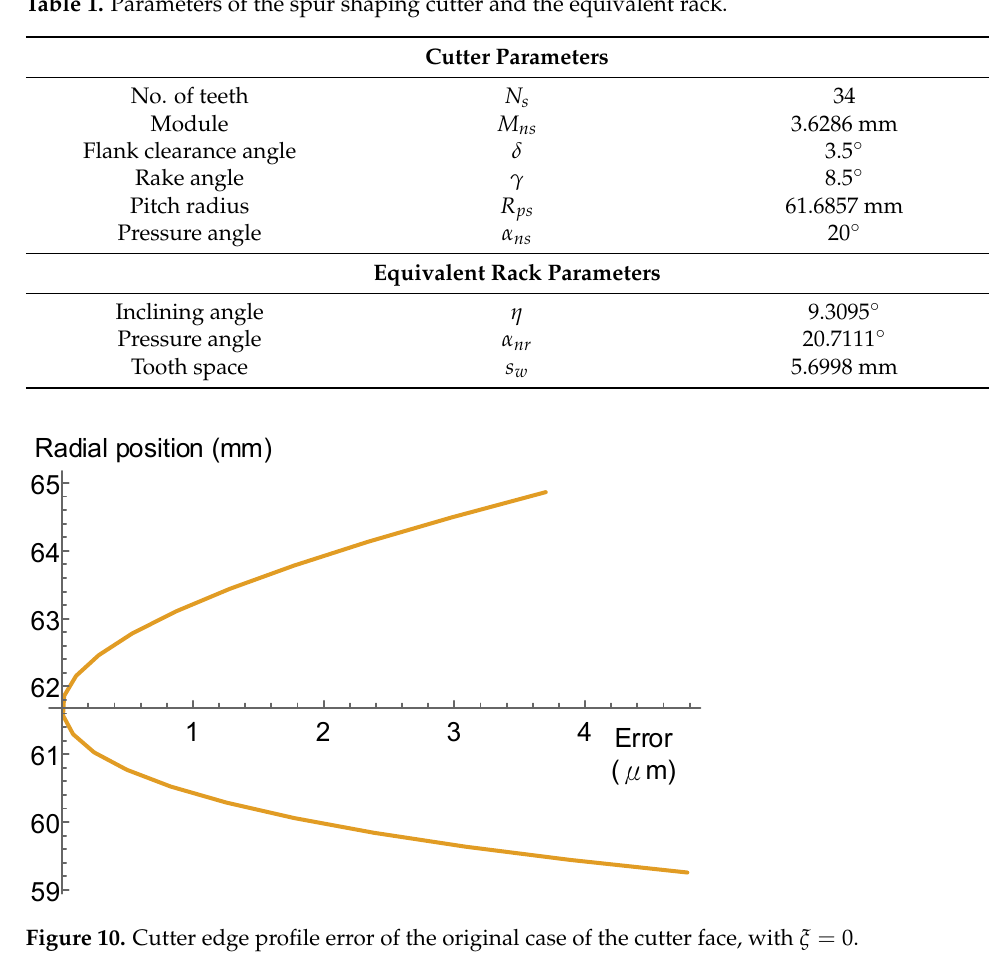
Figure 11. Cutter edge profile error of the curvature-corrected case of the cutter face, with 0